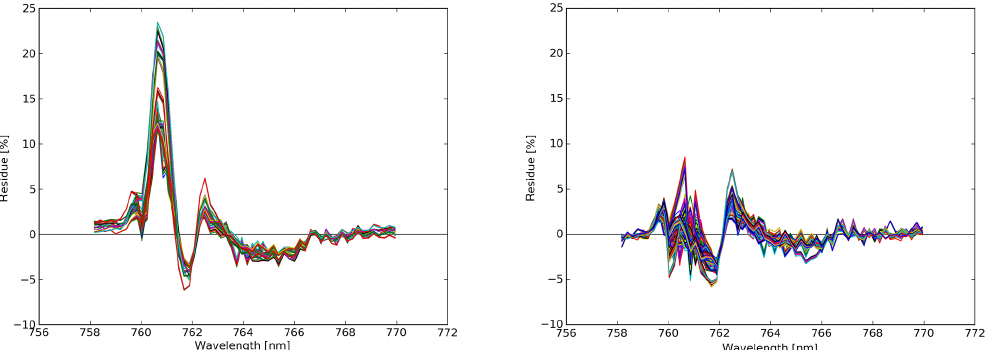
Figure 11. Fit residuals for all converged runs for the 16 GOME-2A target pixels. The default retrieval setup of Sect. 7 is used. Left panel: surface albedo not fitted (see Fig. 6); right panel: surface albedo fitted (see Fig. 7). Relative residues are defined as ( R meas − R fit )/R meas · 100%.